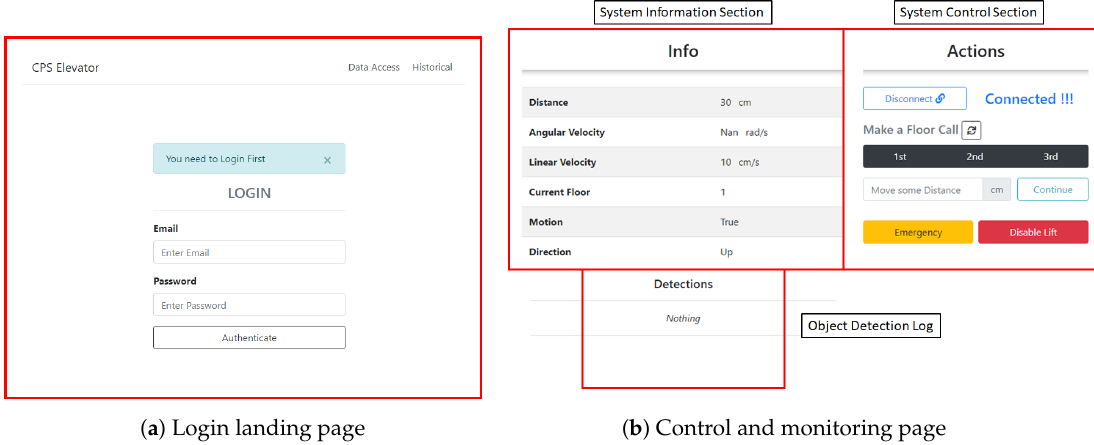
Figure 7. Web access platform.